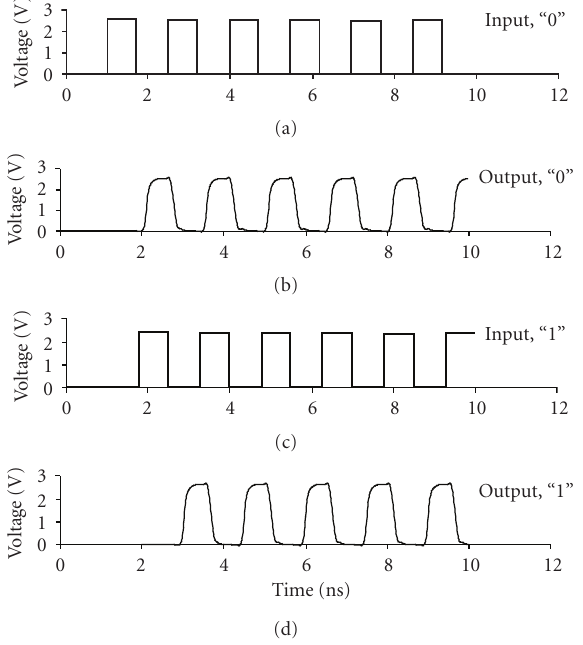
Figure 11: Simulation results of a PQ-cell performing an XOR function. Figure 12: The PQ-cell current profile at (a) 2.5 V and (b) 1.8 V.